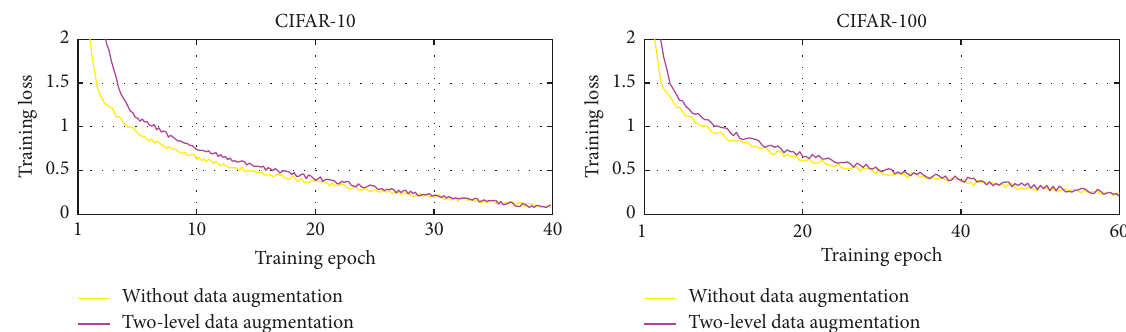
Figure 9: The optimization of the loss function of deep CNNs trained on CIFAR-10 and CIFAR-100,